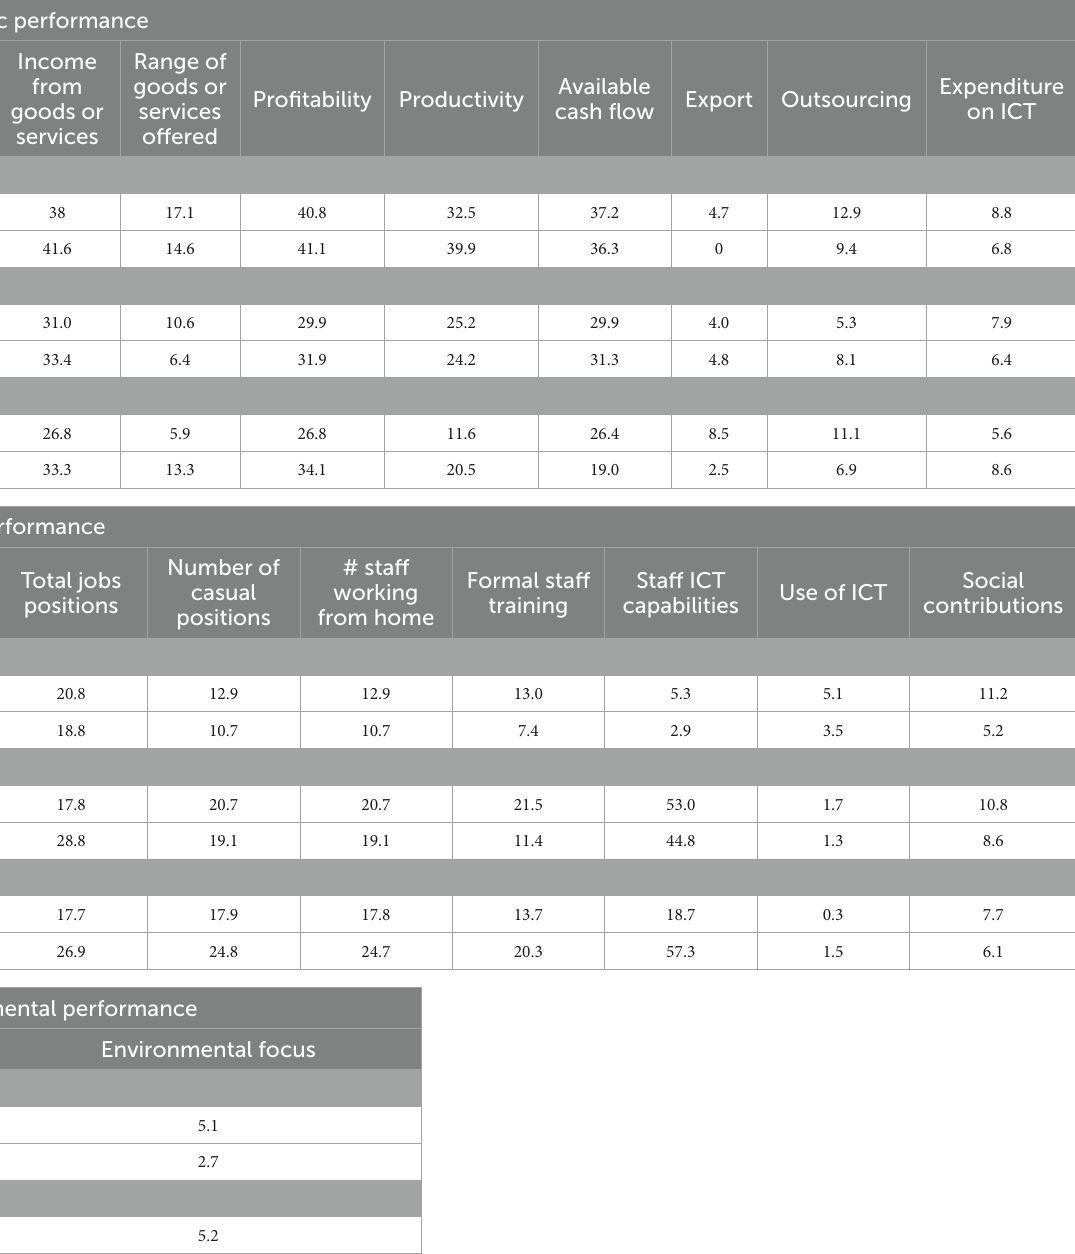
TABLE 2 Percentage of businesses with decreased performance. Panel A. Economic